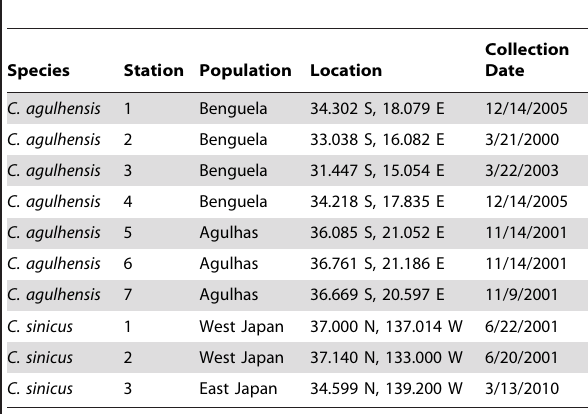
Table 1. Collection information for samples used in the multi- gene analysis.